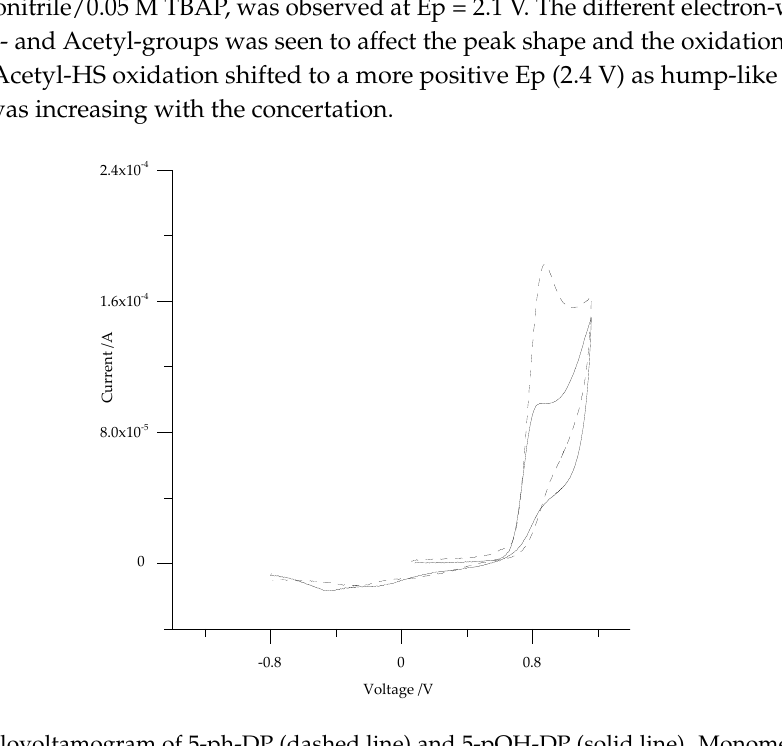
Figure 2. Cyclovoltamogram of 5-ph-DP (dashed line) and 5-pOH-DP (solid line). Monomers were separately investigated at a concentration of 1 mM in AN/0.05 M TBAP. Pt-quartz crystal WE, Ag/Ag + non-aqueous RE, Pt-wire AE, scan rate 50 mVs − 1 .